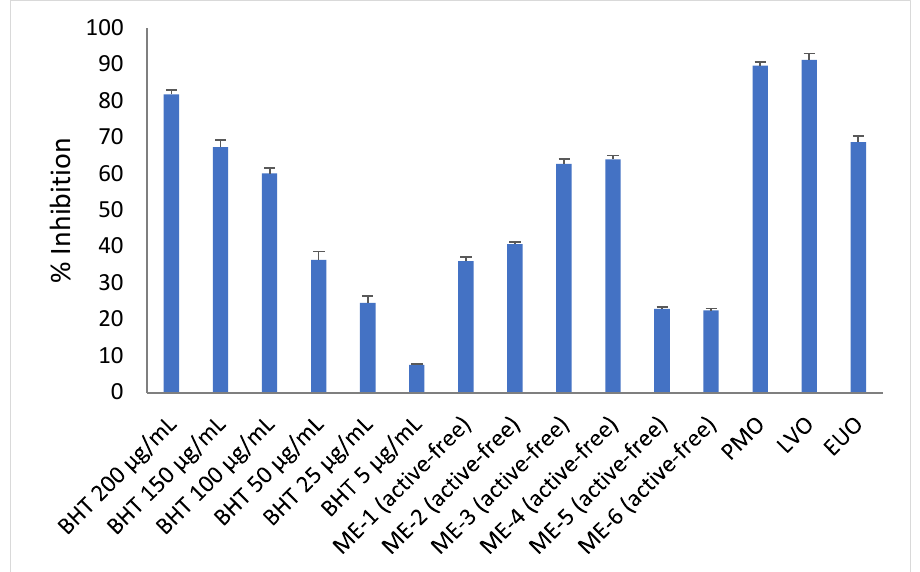
Figure 8. DPPH scavenging activity of pure essential oils, active-free microemulsions of essential oil (MEs) and BHT of various concentrations. Each data point represents the mean ± SD (n = 3). The amount of BHT used in skin care formulations can range from a concentration of 0.0002% to a concentration of 0.5% [34]. Hence, incorporation of synthetic antioxidant such